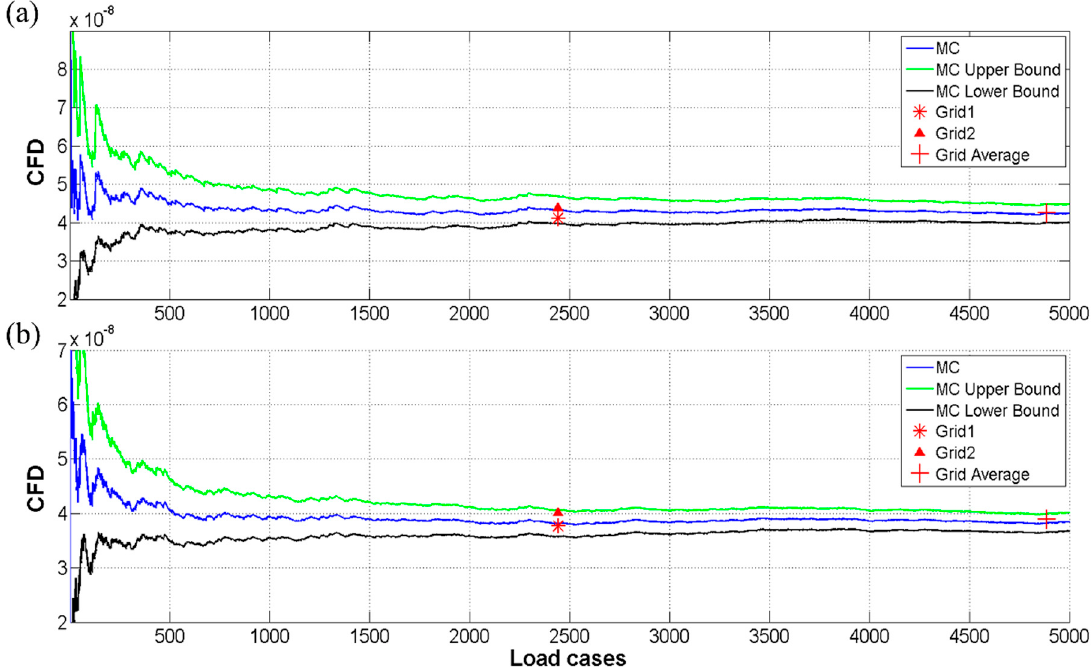
Figure 10. CFD results of the grid-based and Monte Carlo (MC) methods with 95% confidence interval for a hot spot of the ( a ) K and ( b ) KK joints.